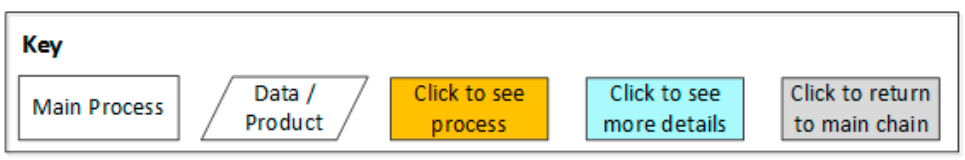
Figure 3. Traceability Chain Key.